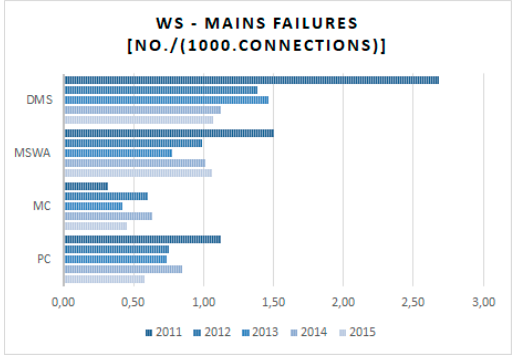
Figure 7. Evolution of water supply failures.